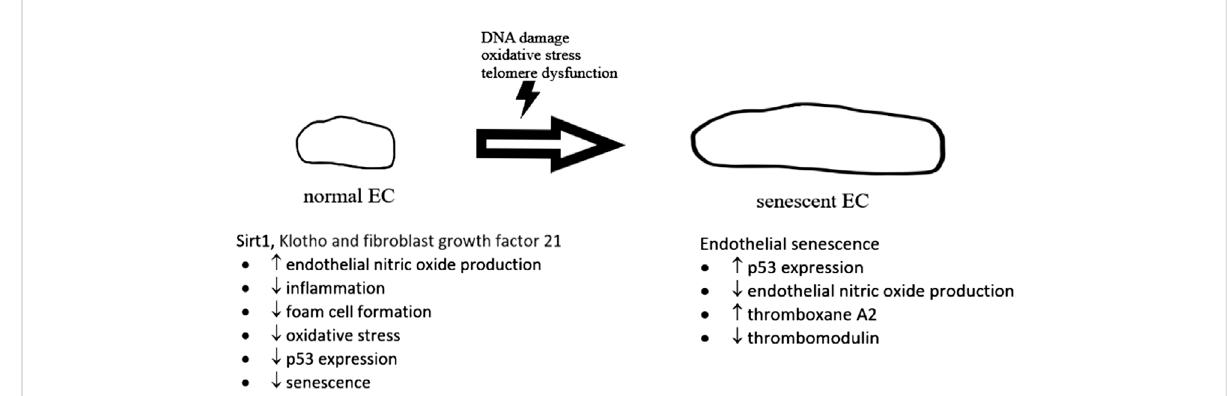
FIGURE 2 The development of normal endothelial cell (EC) to senescent EC. In normal situation, sirt 1, Klotho and fi broblast growth factor 21, etc., give protective effects on normal endothelial cells, preventing senescence. In senescent EC, expression of p53 was upregulated with a reduction of endothelial nitric oxide